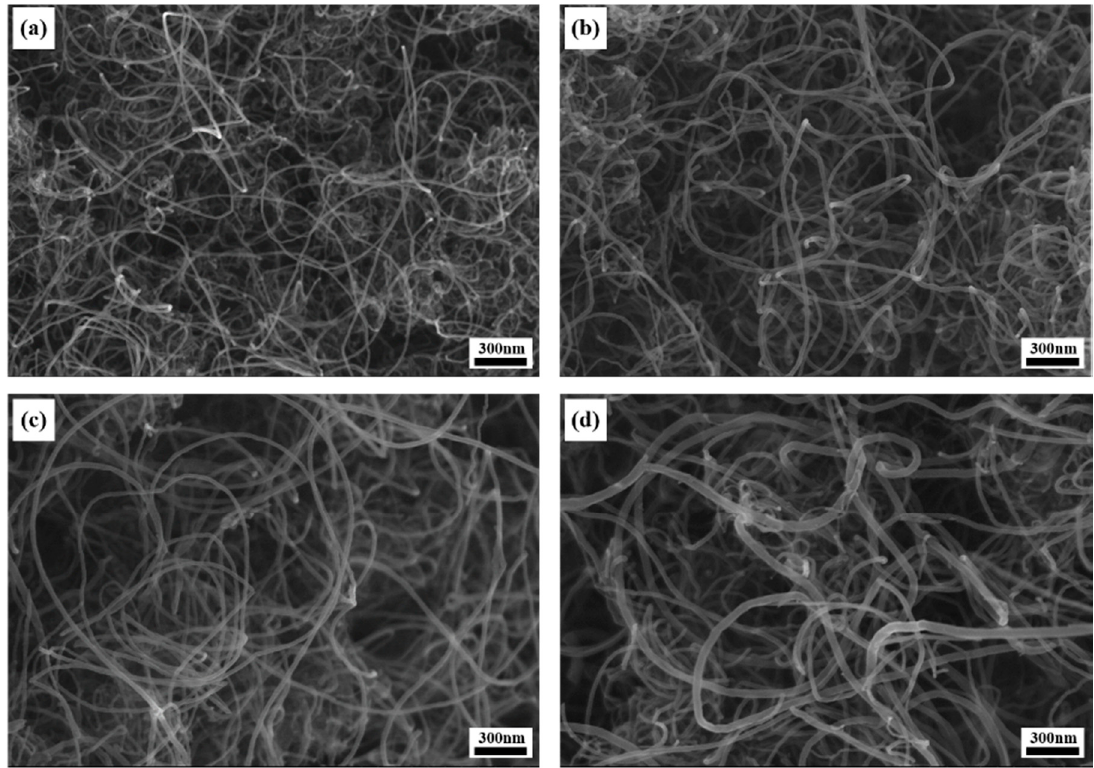
Figure 4. Scanning electron microscope (SEM) image of CNTs grown by using the Fe–Co/MgO catalyst reduced at ( a ) 600, ( b ) 700, ( c ) 800, and ( d ) 900 °C, respectively.